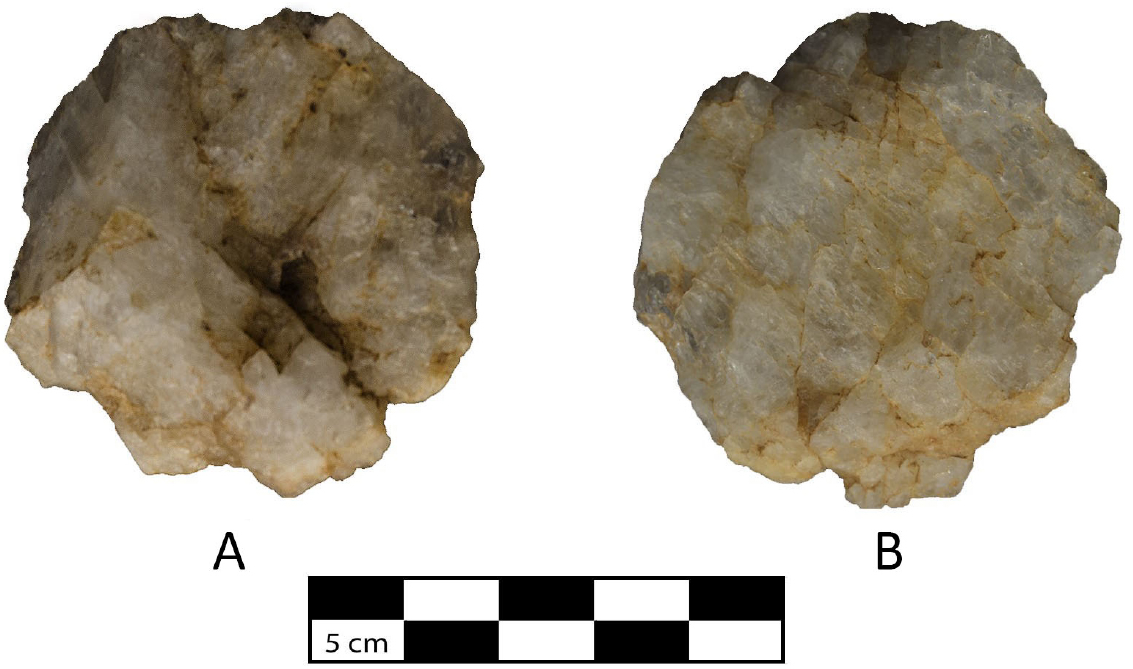
Figure 4. A discoidal preferential flake core. (A) dorsal and (B) ventral. The raw material is quartz.